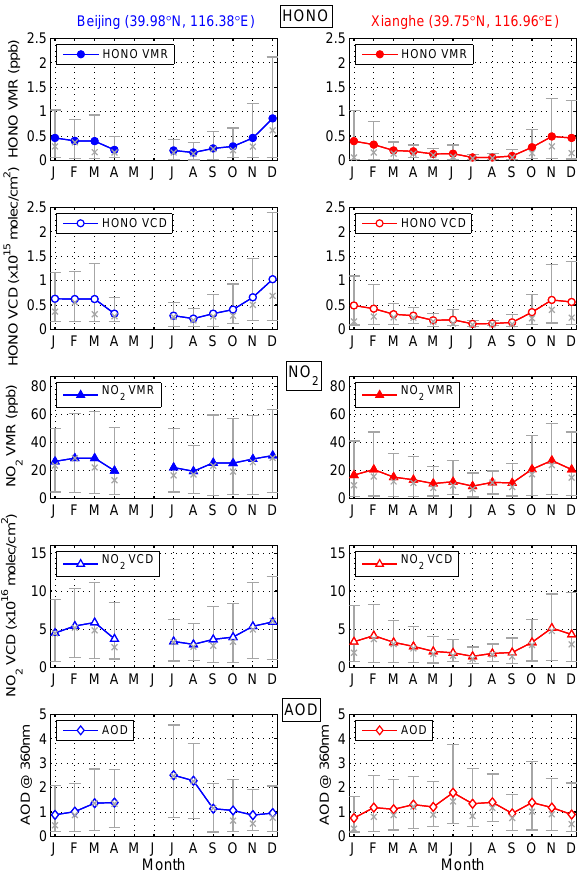
Fig. 9. Seasonal variation of the HONO to NO 2 near-surface con- centration ratio, the HONO to NO 2 VCD ratio, and the HONO ver- sus NO 2 , HONO versus aerosol, and NO 2 versus aerosol correlation coefficients (0–200m VMR and vertical column density (VCD)) at local noon at Beijing (left plots) and Xianghe (right plots). In the two upper plots, the cross symbol and the lower (upper) error bars represent the median and the 10th (90th) percentiles of the data,